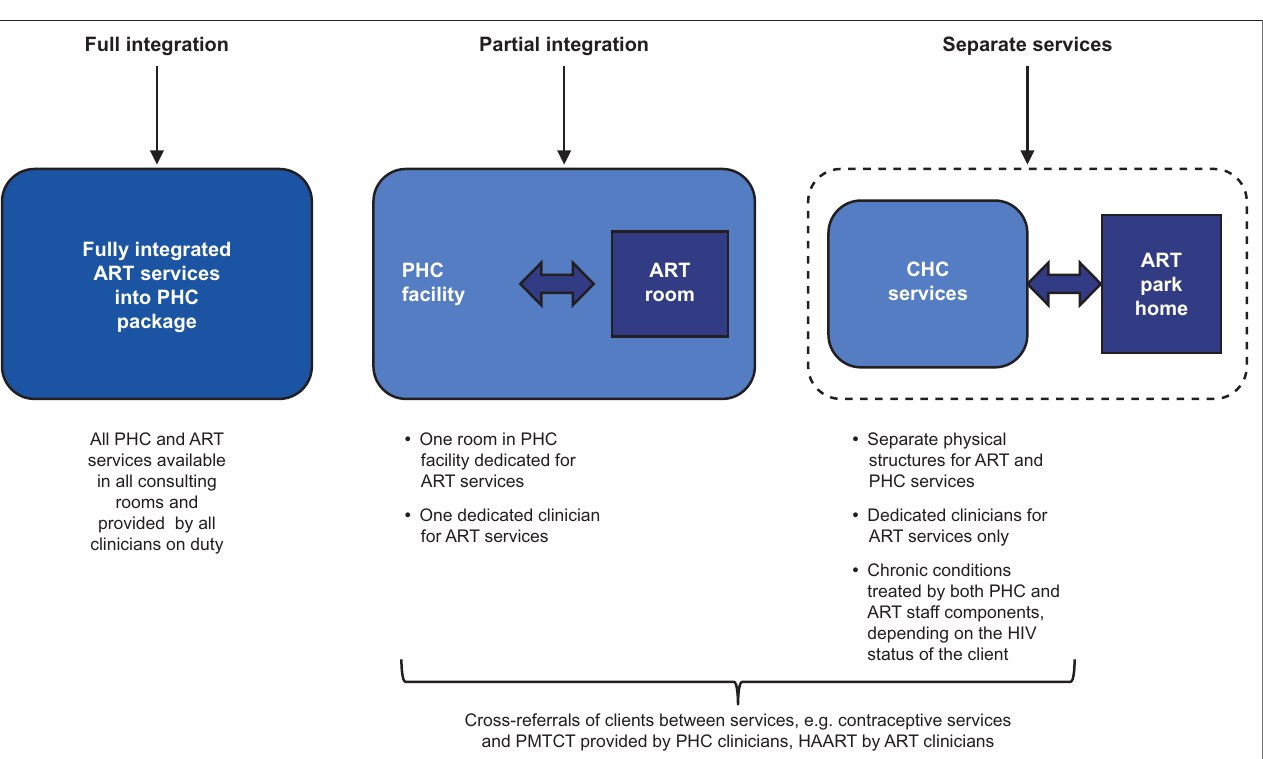
FIGURE 1: Antiretroviral treatment service integration models at primary health care PHC facilities.